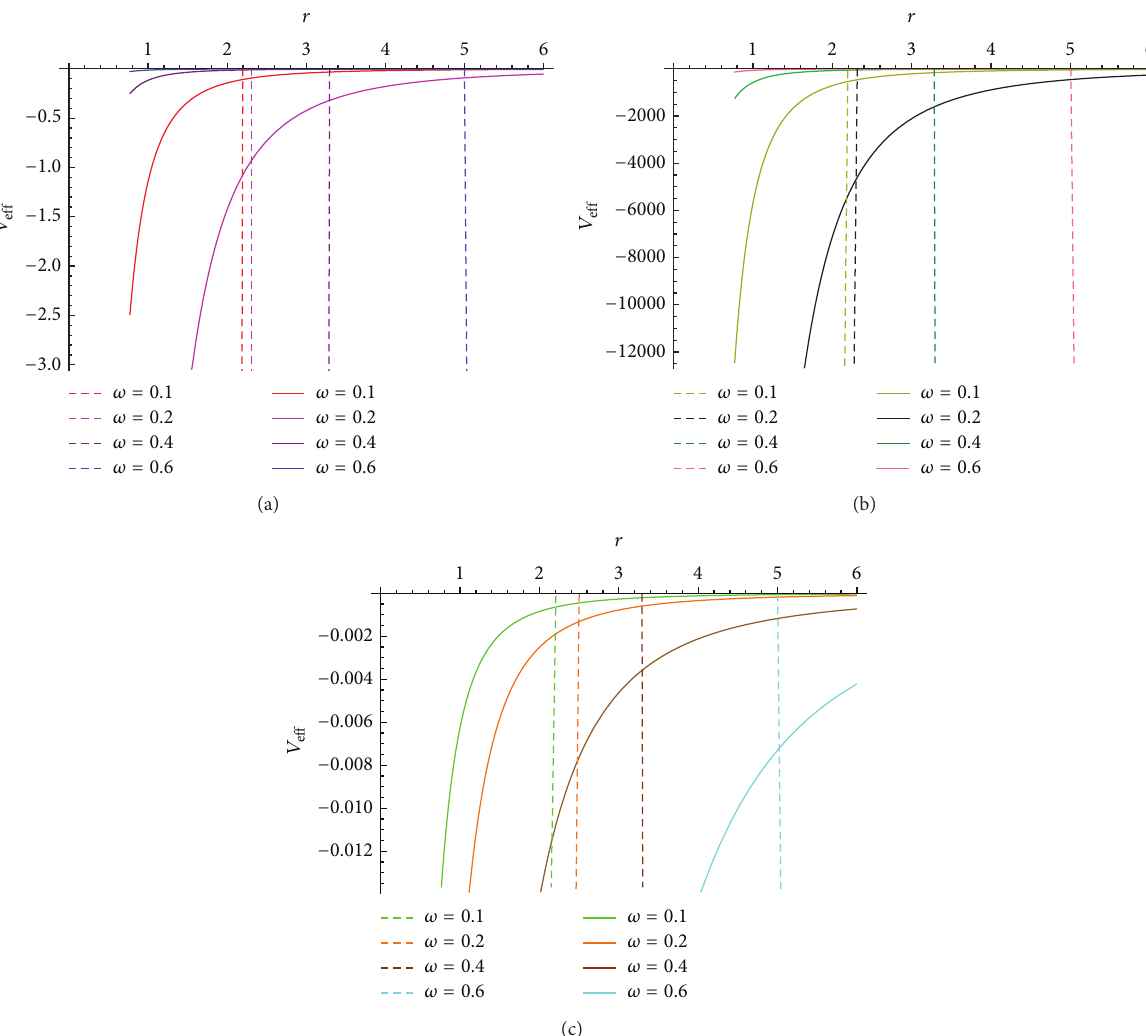
Figure 1: Behavior of the effective potential (𝑉 and dashed lines correspond to 𝑉